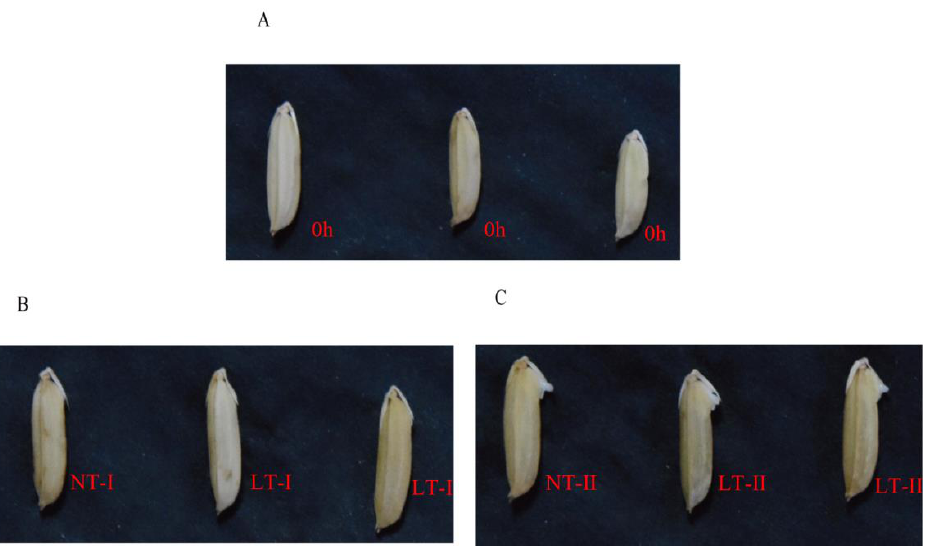
Figure 1. Dynamic changes in seed germination of cultivar Francis under NT (25 °C) and LT (15 °C) conditions. ( A ) 0 h: untreated dry seeds. ( B ) NT-I or LT-I: seeds germinated at 25 °C or 15 °C; the embryos had just broken out of the glumes. ( C ) NT-II or LT-II: seeds germinated at 25 °C or 15 °C; embryo length was ≥1.0 mm.